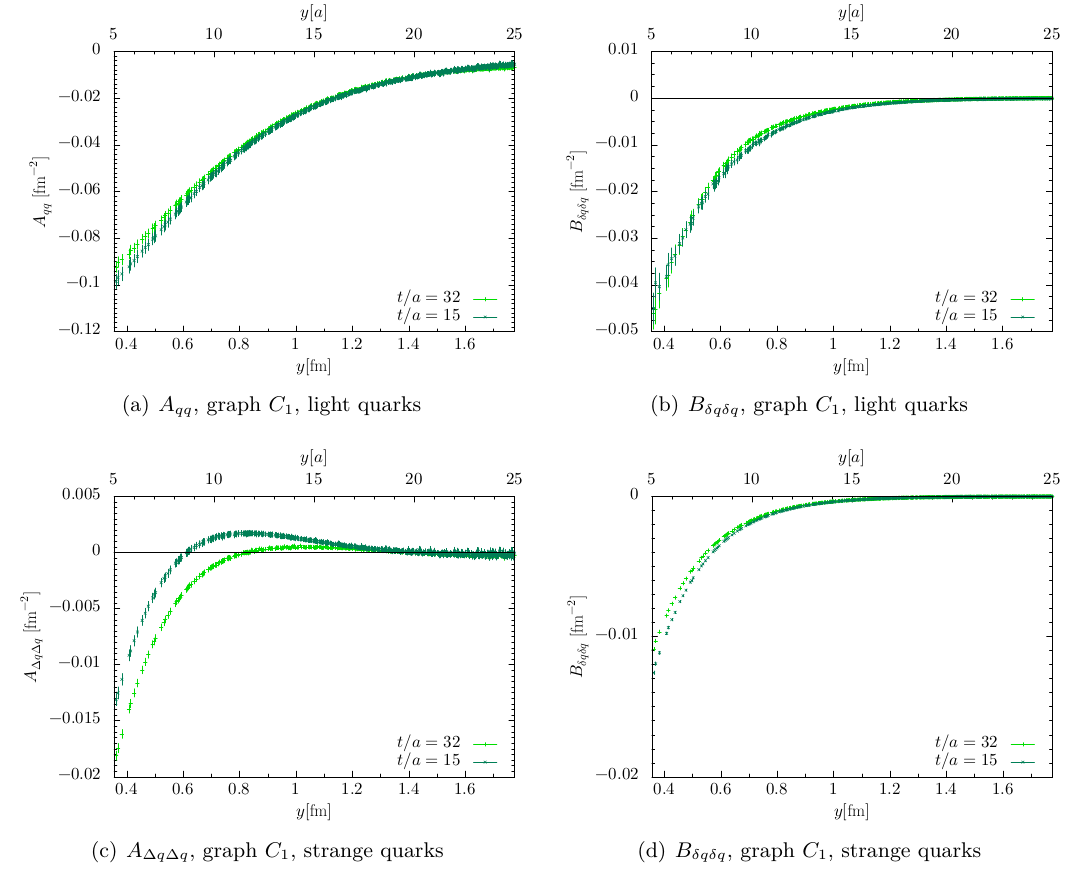
Figure 10 . Comparison of twist-two functions extracted for graph C 1 with source-sink separations t/a = 15 or 32 . All data are for L = 40 , zero pion momentum, and subject to the cut